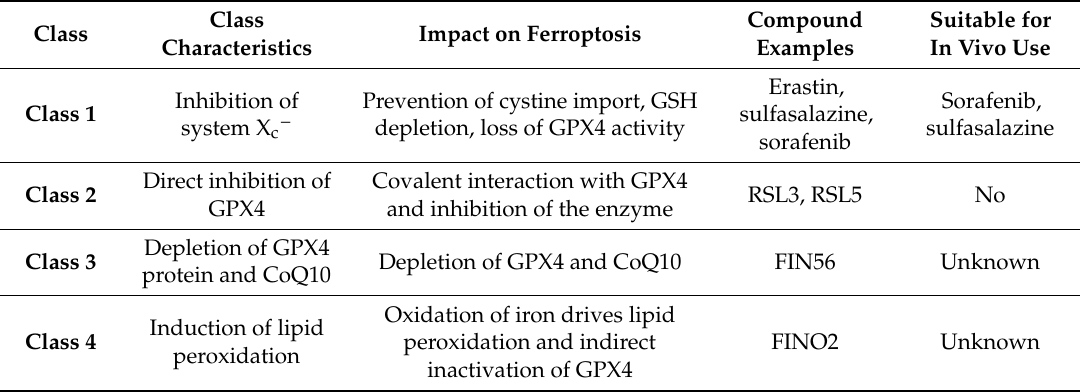
Table 2. Ferroptosis inducers (adapted from